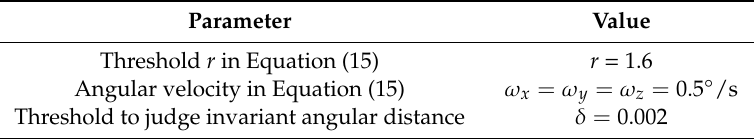
Table 2. Parameters of the proposed